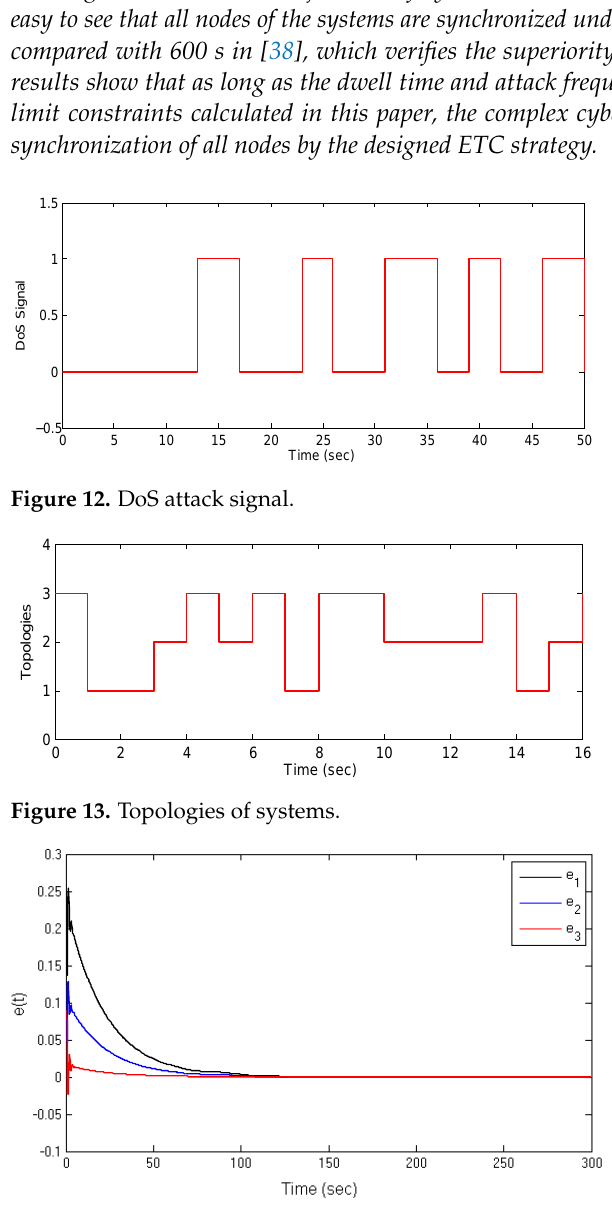
Figure 14. Error trajectories of nodes under DoS